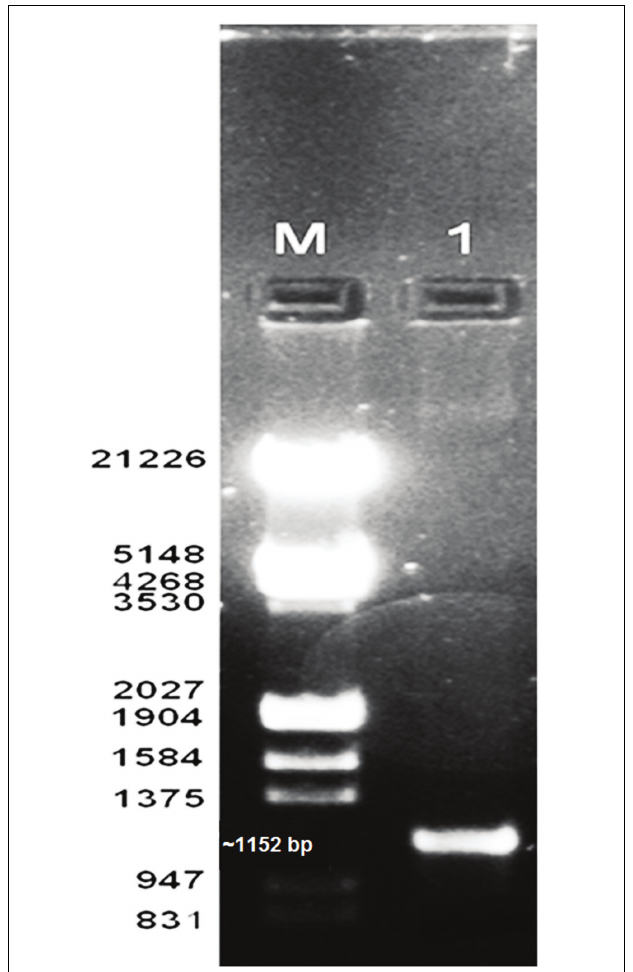
FIGURE 5 | Amplification of protease gene (M) Marker (1) amplified